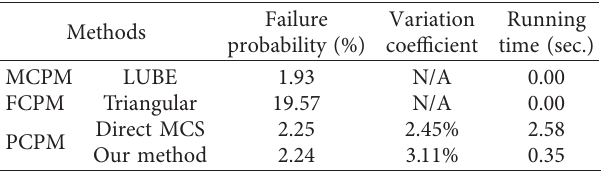
Figure 7: Hypothetical schedule network. Table 1: Schedule network failure evaluation comparison (dead- line � 85 days).